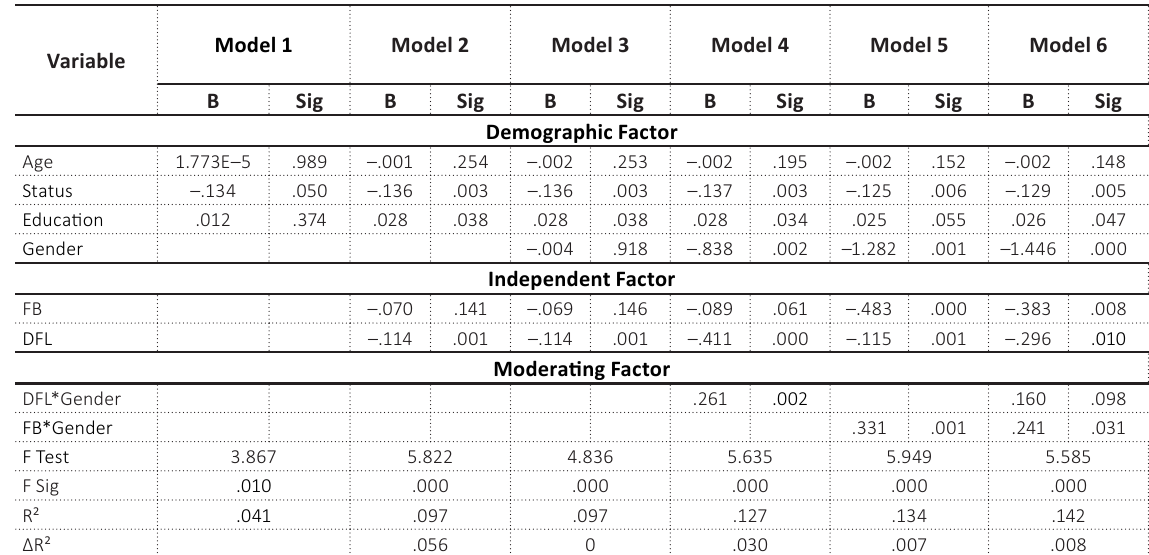
Table 3. Hypothesis testing